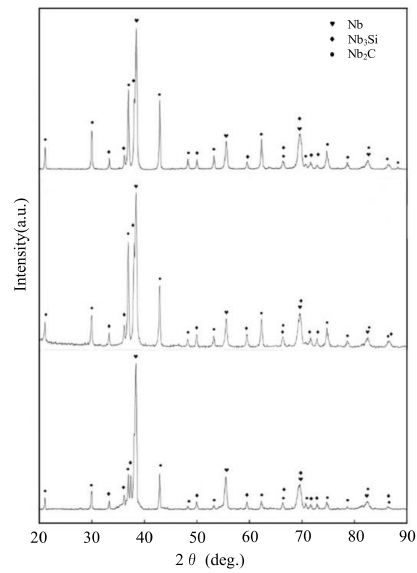
Figure 5. XRD patterns of Nb-xSiC composites.